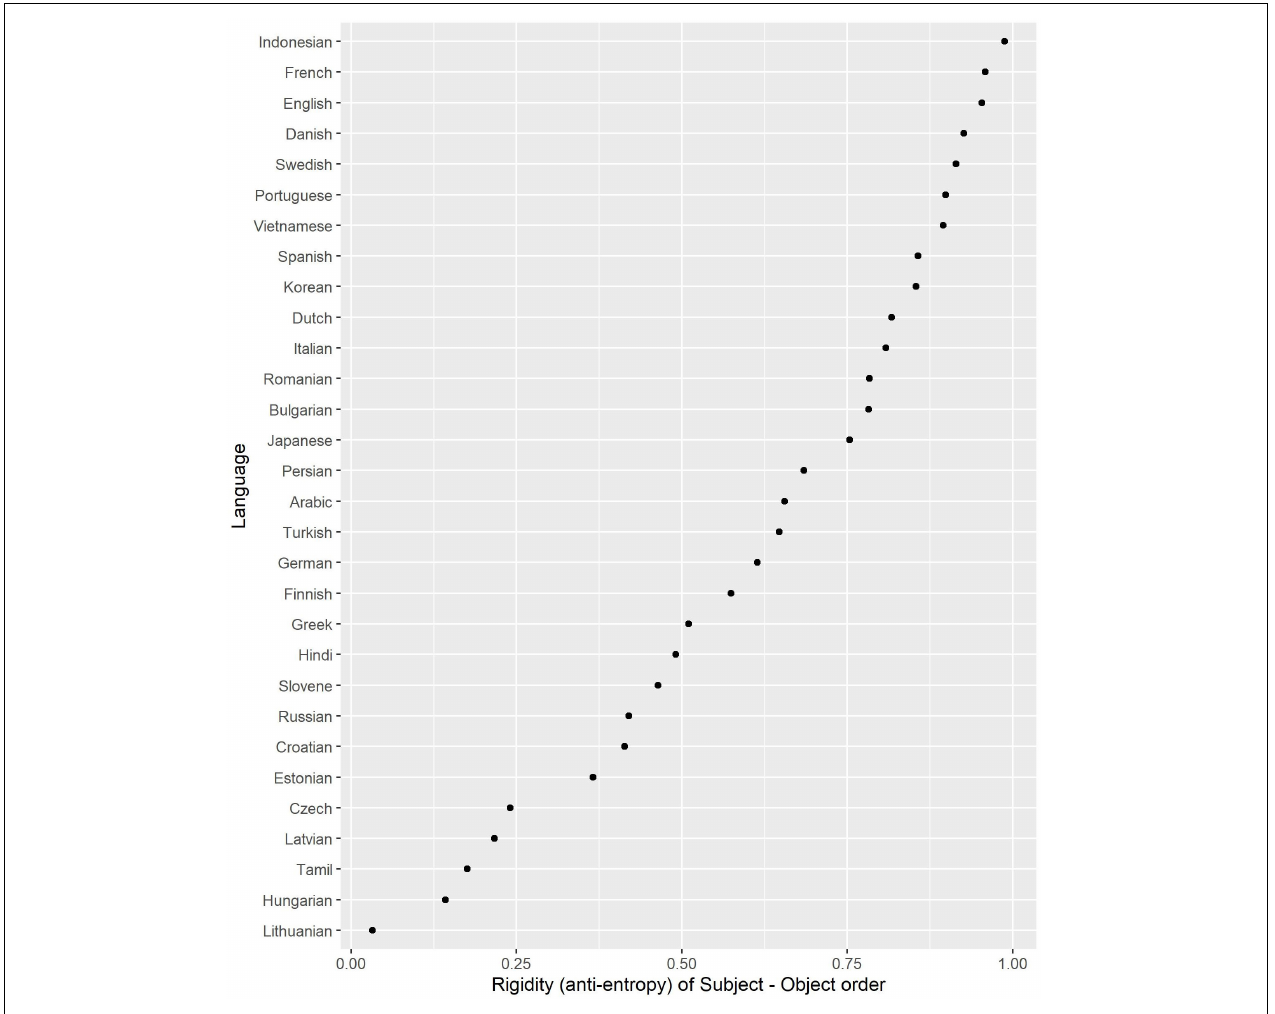
FIGURE 3 | Rigidity of Subject – Object order (1 –